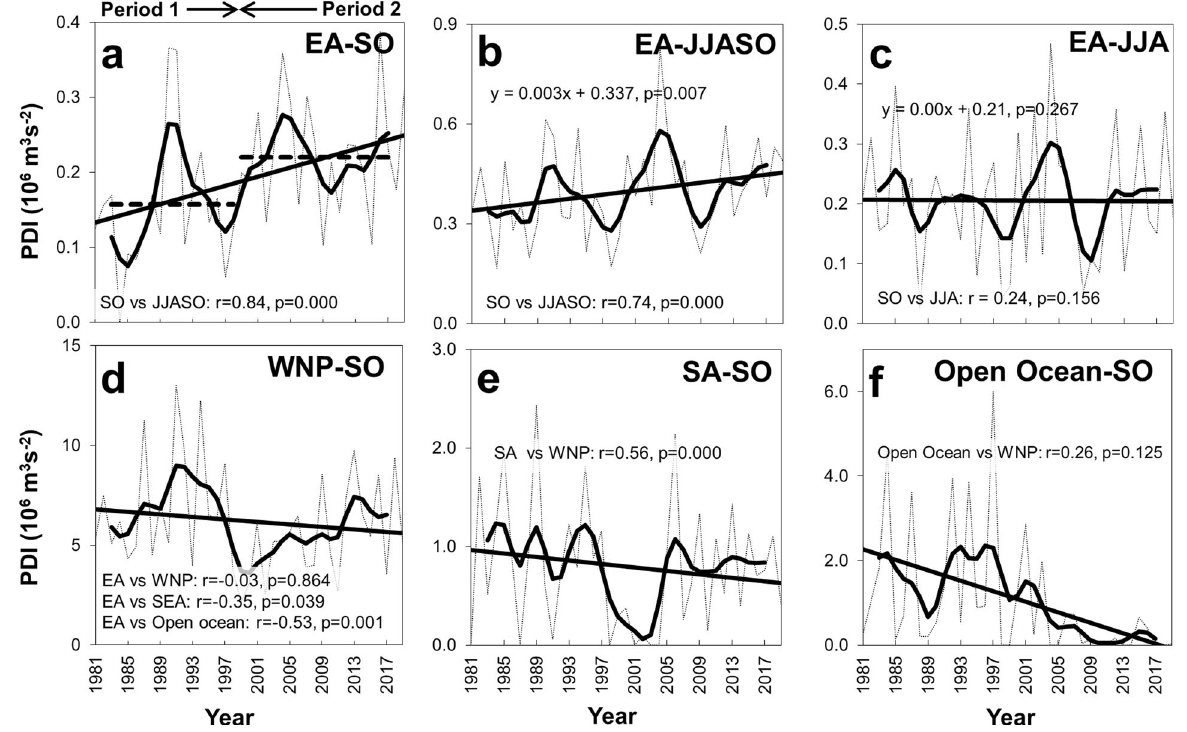
Fig. 2 Increasing activity of tropical cyclones in East Asia during the mature boreal autumn. a − c Timeseries of Power Dissipation Index (PDI) in East Asia (EA) during September − October (SO), June − October (JJASO), and June − August (JJA), respectively. d – f Timeseries of PDI during the SO in the Western North Paci fi c (WNP), Southeast Asia (SA), and in the open ocean, respectively. The thick (thin) line represents the timeseries of the 1-3-4-3-1 fi ltered (raw) PDI. In a the black dashed lines indicate the abrupt regime shift in PDI during the Period 1 (1981 − 1997) and Period 2 (1998 − 2019), respectively. Signi fi cance is tested using student ’ s t-test statistic with two-tailed